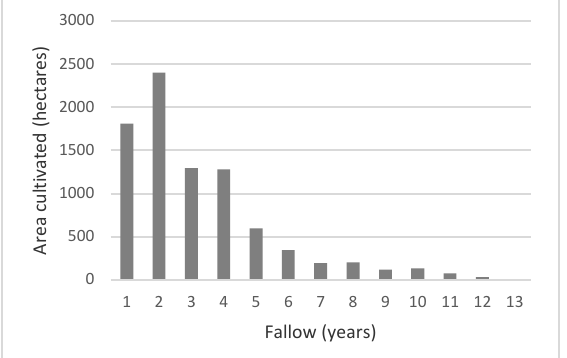
Figure 6: Chart showing the total area in hectares cultivated under various fallow periods Fallow period (years)